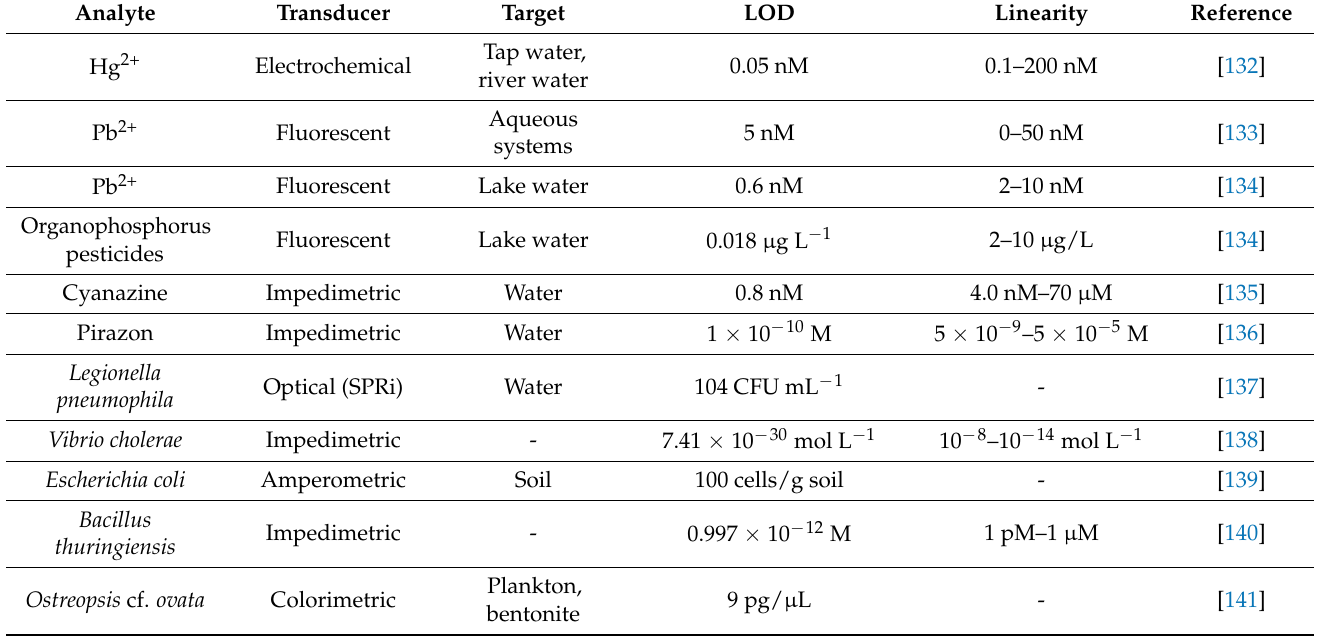
Table 6. Examples of DNA-based biosensors used for environmental